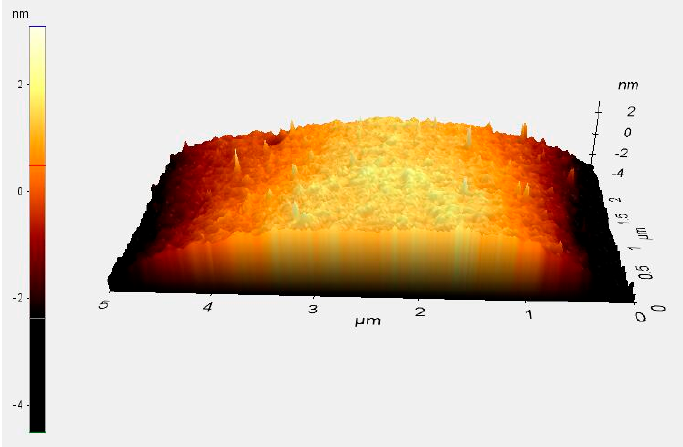
Figure 10. Atomic force microscopy (AFM) graph of glass surface after annealing.